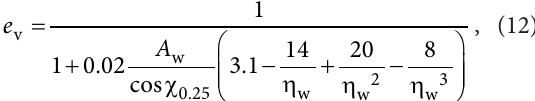
Figure 2. m win2 / m win1 ratio depending on wing sweep angle c 2